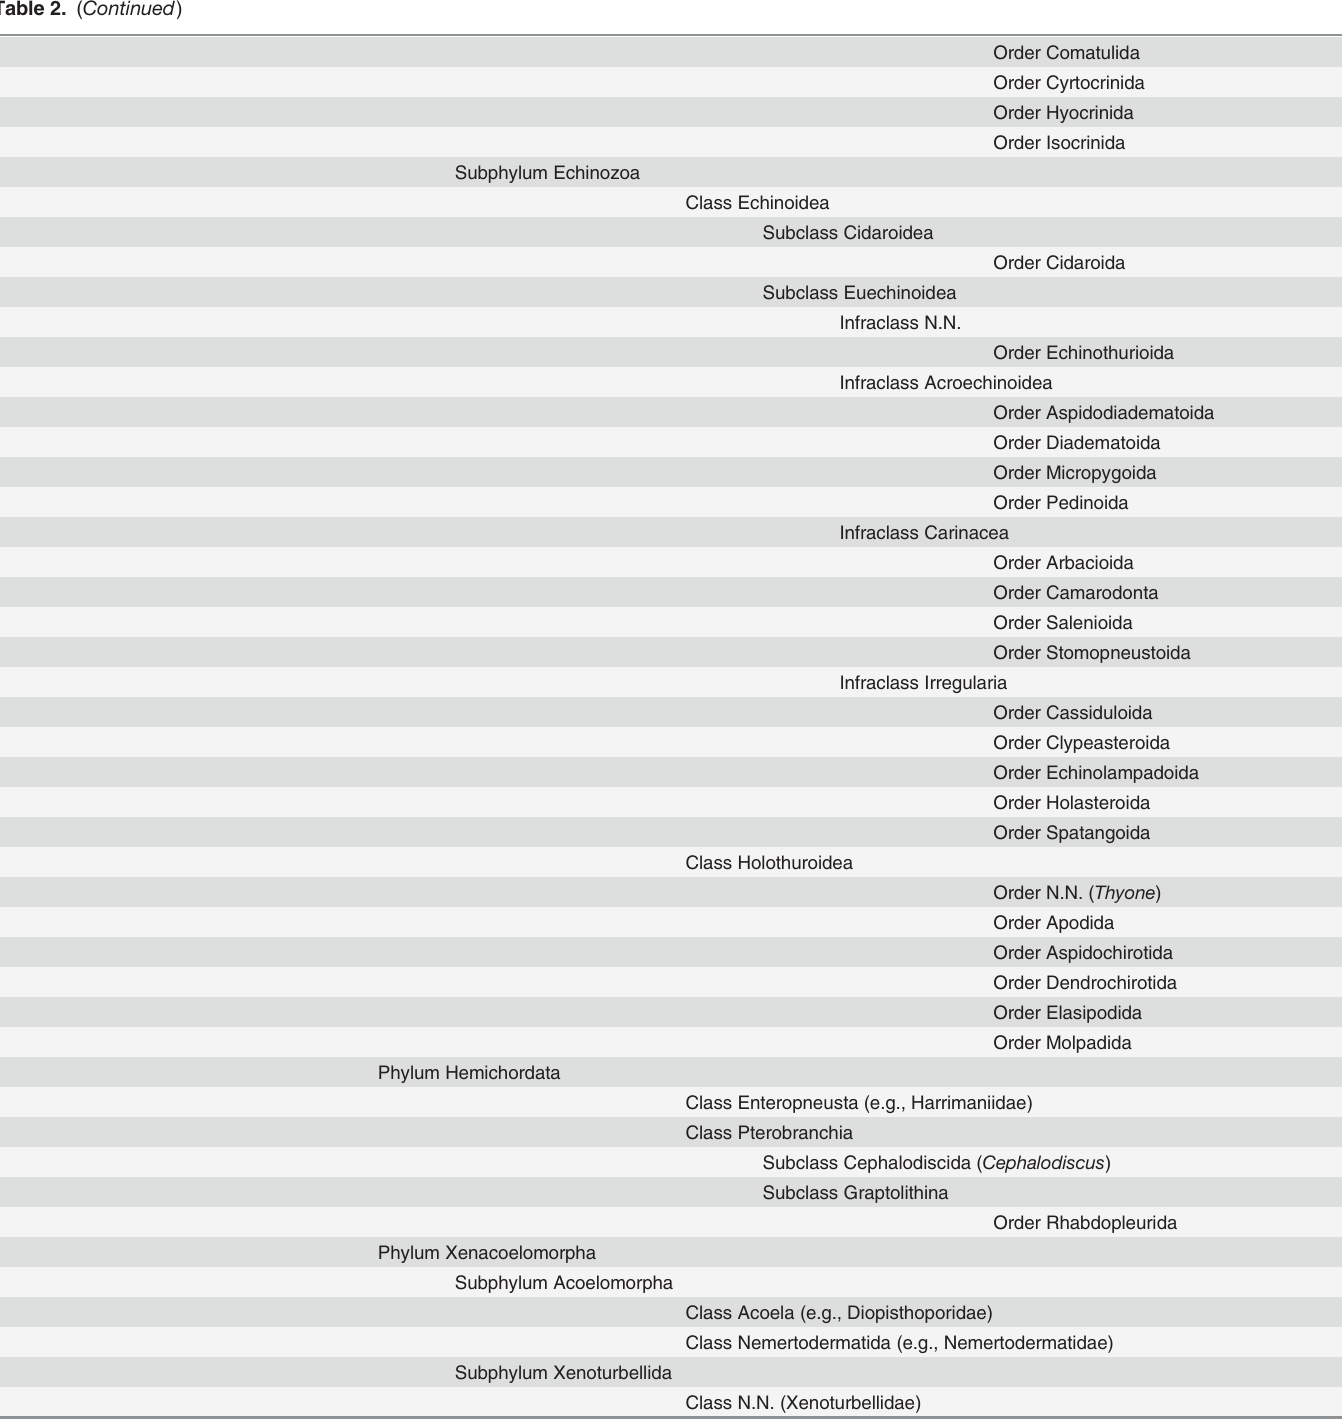
synonyms. Quoted names are not validly published but in common